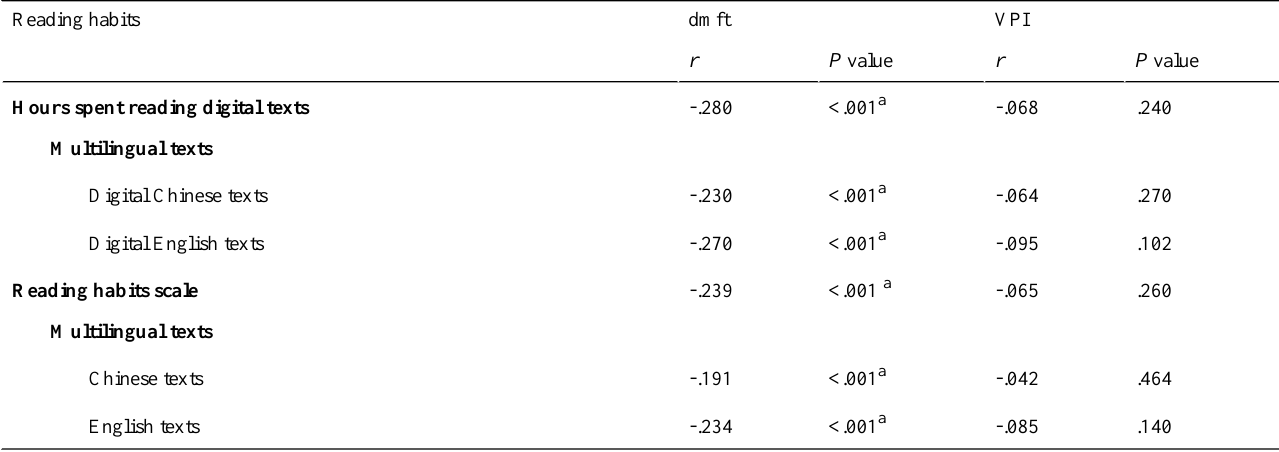
Table 2. Correlations (Spearman correlation coefficient) between caregivers’ reading habits (multimodal, multilingual) and their child’s oral health status. VPIdmftReading